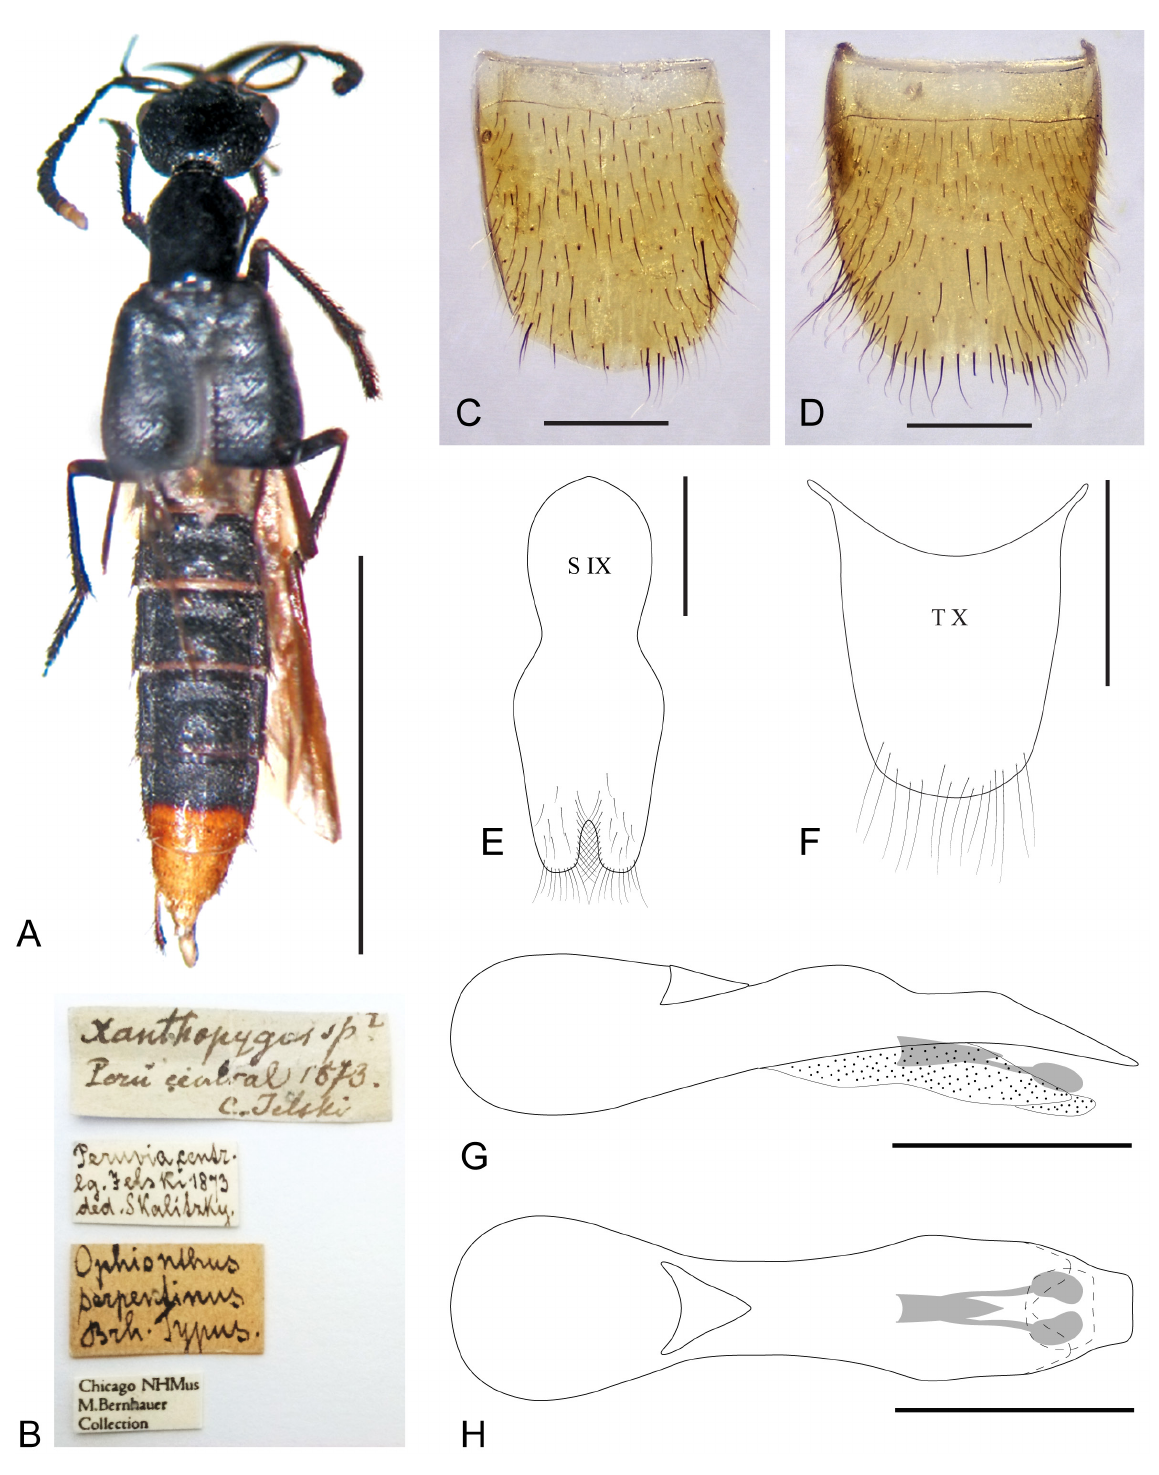
Fig. 1. Ophionthus serpentinus Bernhauer, 1908. Holotype, ♂ (FMNH). A . Habitus, dorsal view, after Chani-Posse (2014a). B . Original labels. C . Tergum VIII. D . Sternum VIII. E . Sternum IX. F . Tergum X. G . Aedeagus, lateral view. H . Aedeagus, dorsal view. Stippled areas in G represent membranes. Shadded areas in G and H represent internal sclerites Scale bars: A = 5 mm; C–H = 0.5